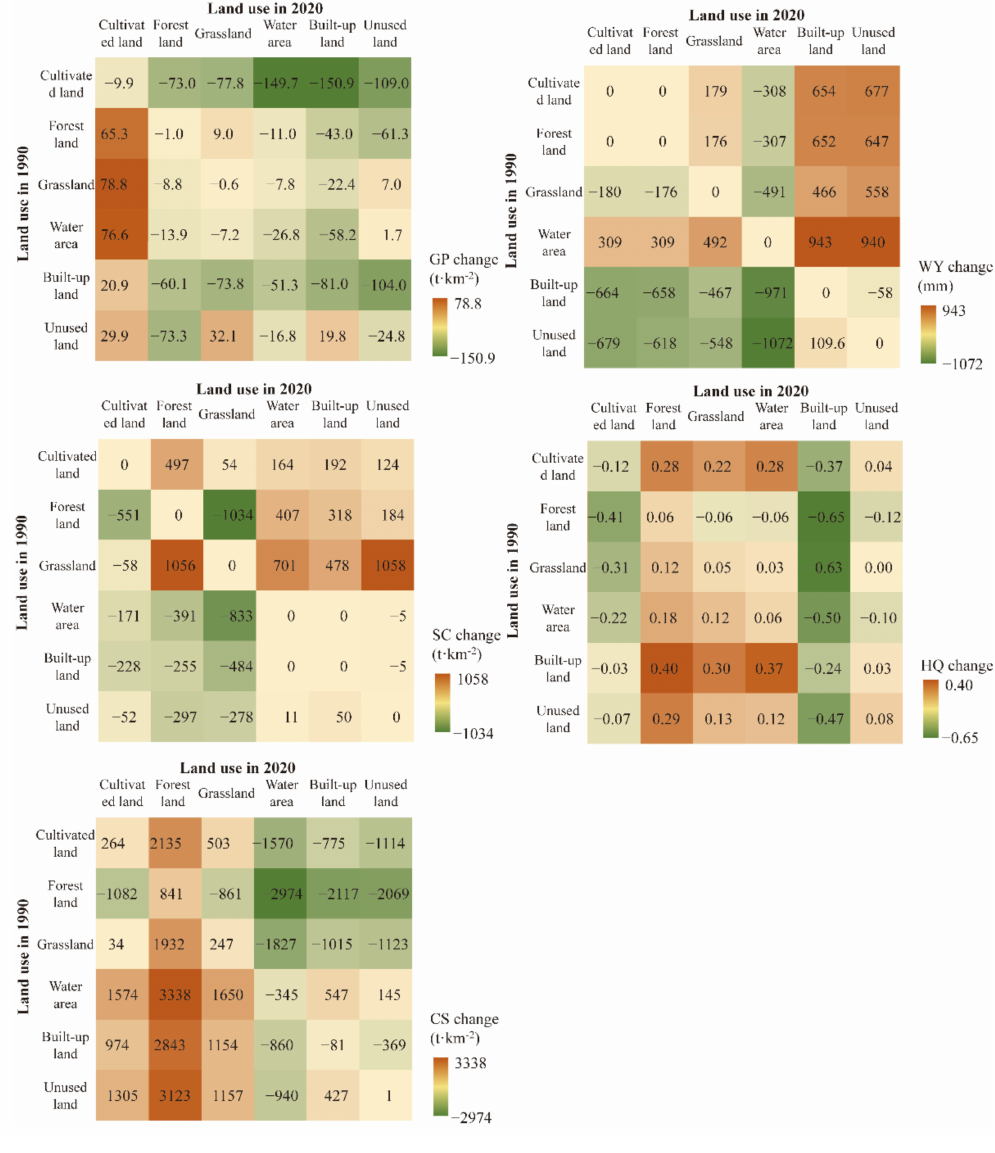
Figure 6. Average change of the five key ecosystem services corresponding to different land use conversion types in Guangdong province,